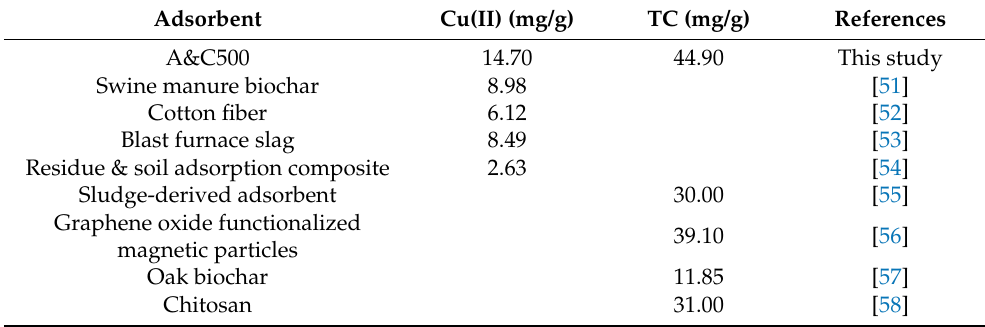
Table 1. Comparison of adsorption capacity for Cu( Ⅱ ) and TC by different adsorbents.